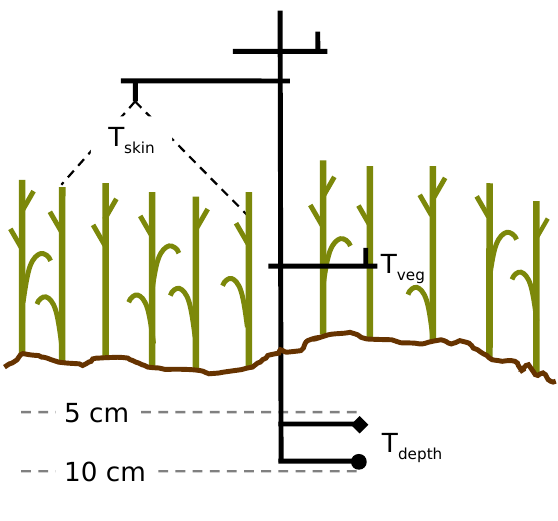
Figure 3. Vegetation and soil temperatures observed by flux towers in the South Fork. T depth was located at 6cm in 2015 ( (cid:7) ) and 9cm in 2018 ( •